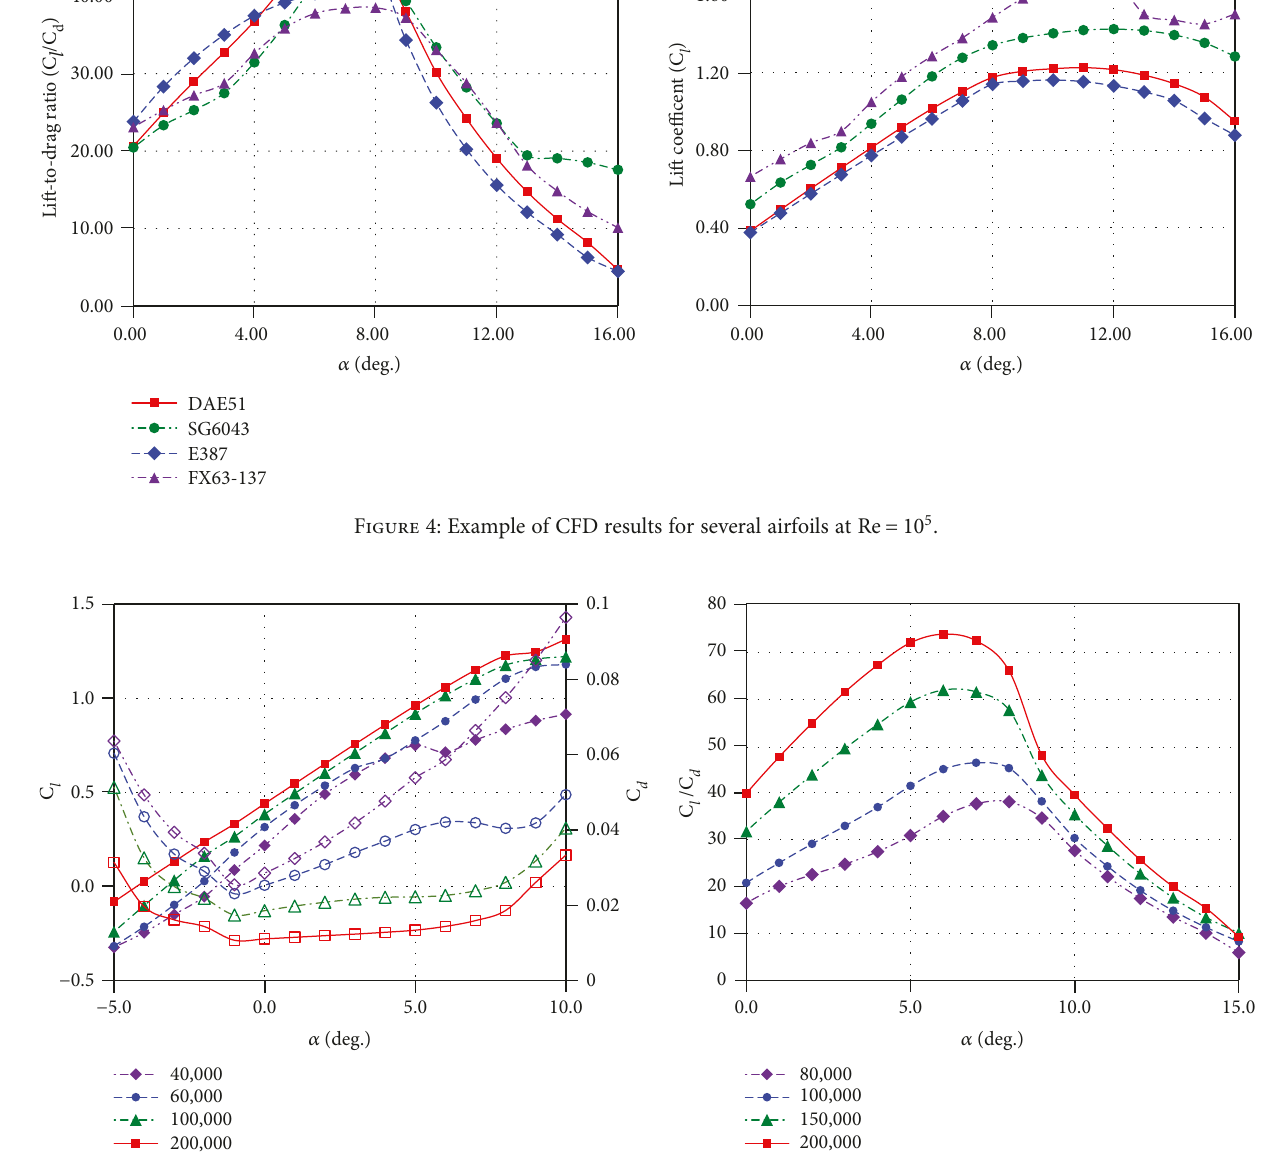
Figure 5: Example of aerodynamic data of DAE51 obtained by CFD. Table 3: Design variables. Table 4: Values of design variables for example